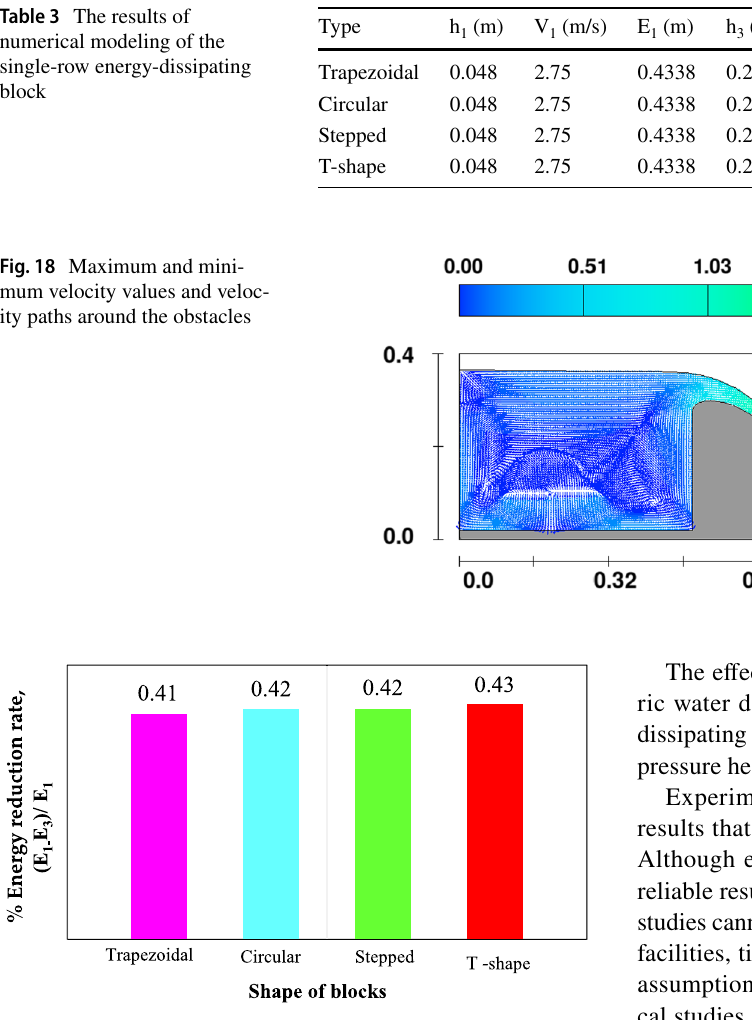
Fig. 19 E nergy-dissipating rates obtained by numerical modeling for the single-row energy-dissipating block for maximum discharge of Q = 39.6 l/s